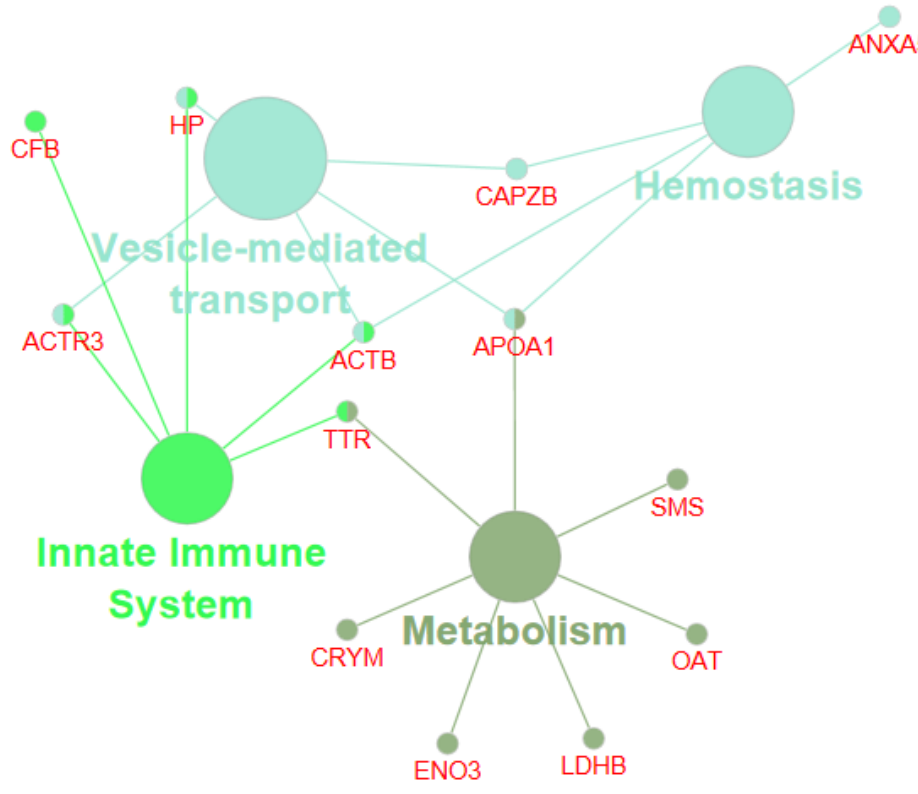
Figure 4. Visualisation of the functionally grouped gene ontology and protein interaction networks of DEPs in porcine en- dometrium. Comparison of the preimplantation (9D) and peri-implantation period (12D) of pregnancy based on pathway’s enrichment significance analysis by Cytoscape ClueGo TM . The nodes’ size reflects the pathway’s enrichment